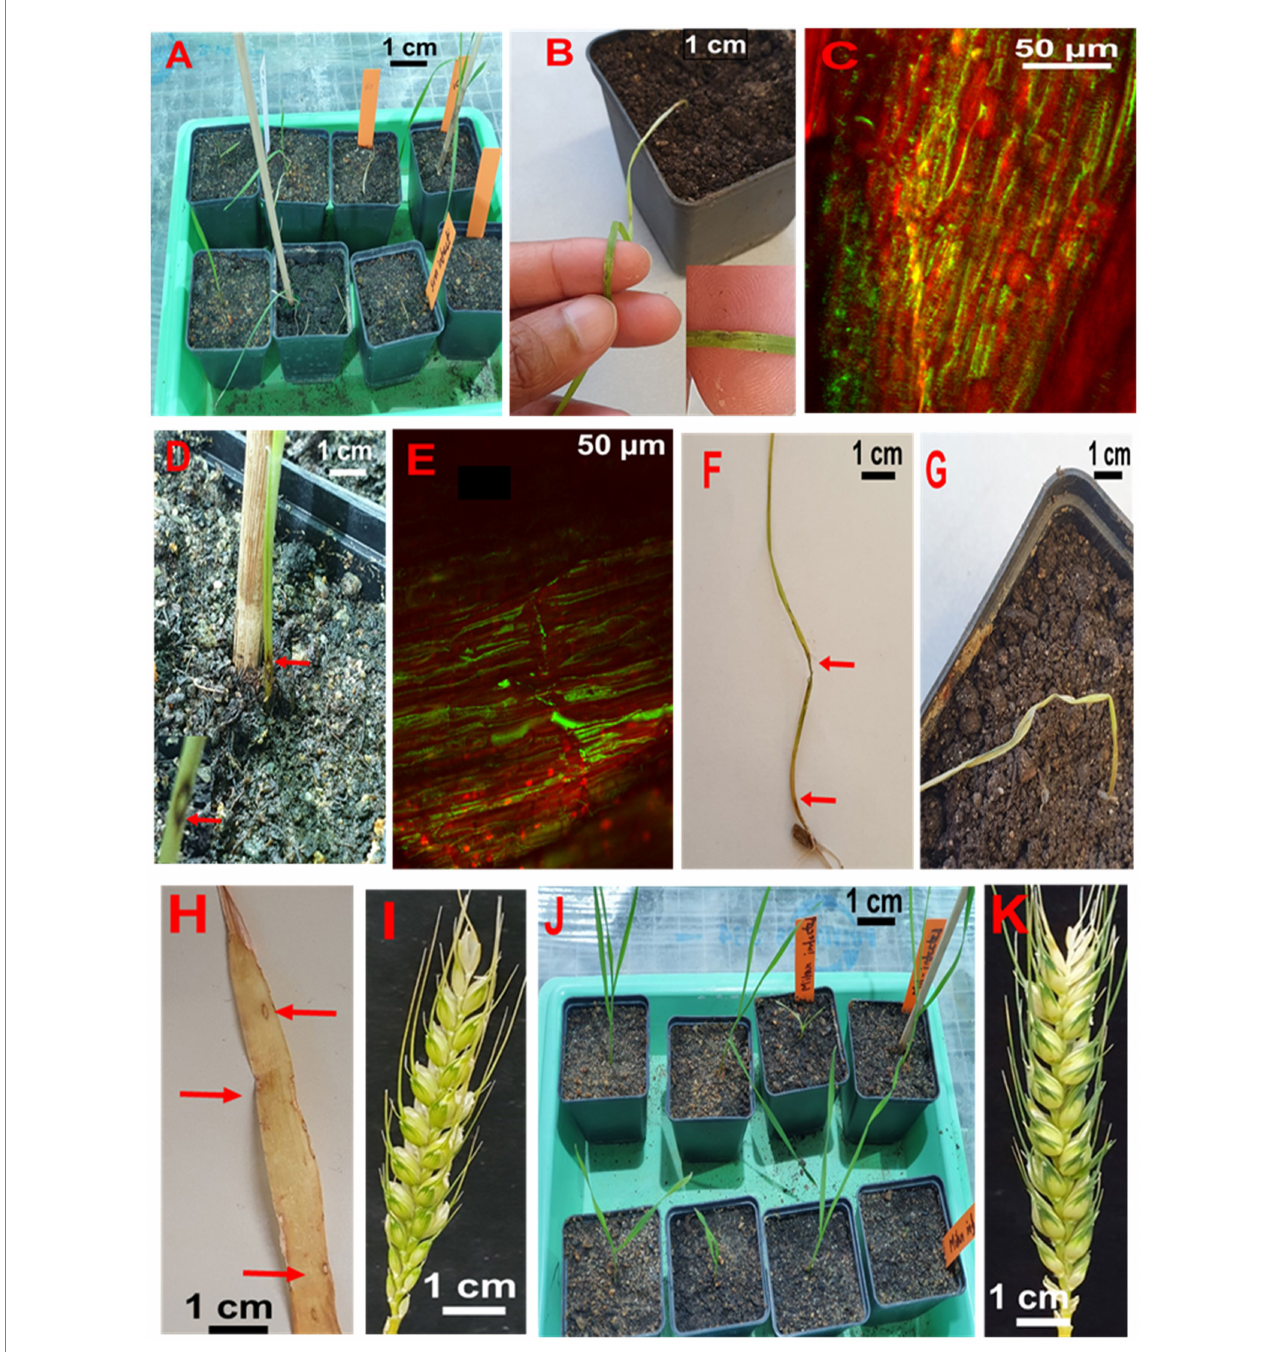
FIGURE 6 Testing seed-to-seed transmission of MoT. (A) Seedlings from infected Sumai 3 seeds in the climate chamber. (B) Characteristic eye-shaped blast symptoms on the first leaf of a Sumai 3 seedling (GS 11). (C) Fungal hyphae in infected Sumai 3 seedling leaf tissue visualized through CLSM. (D) Typical eye-shaped blast symptom on the stem of Sumai 3 (GS 11). (E) Longitudinal section of infected Sumai 3 stem displaying fungal growth in infected stem tissue by CLSM (GS 11). (F) Severely infected Sumai 3 seedling developed from MoT infected seed. (G) Sumai 3 seedling killed through MoT infection (GS 14). (H) Characteristic blast symptoms on older leaves of Sumai 3 (GS 21). (I) Asymptomatic ear from infected seeds of Sumai 3 (GS 65). (J) Seedlings from infected seeds of Milan (GS 11). (K) Asymptomatic ear from infected Milan seeds (GS